Question: How would you classify this visualization?
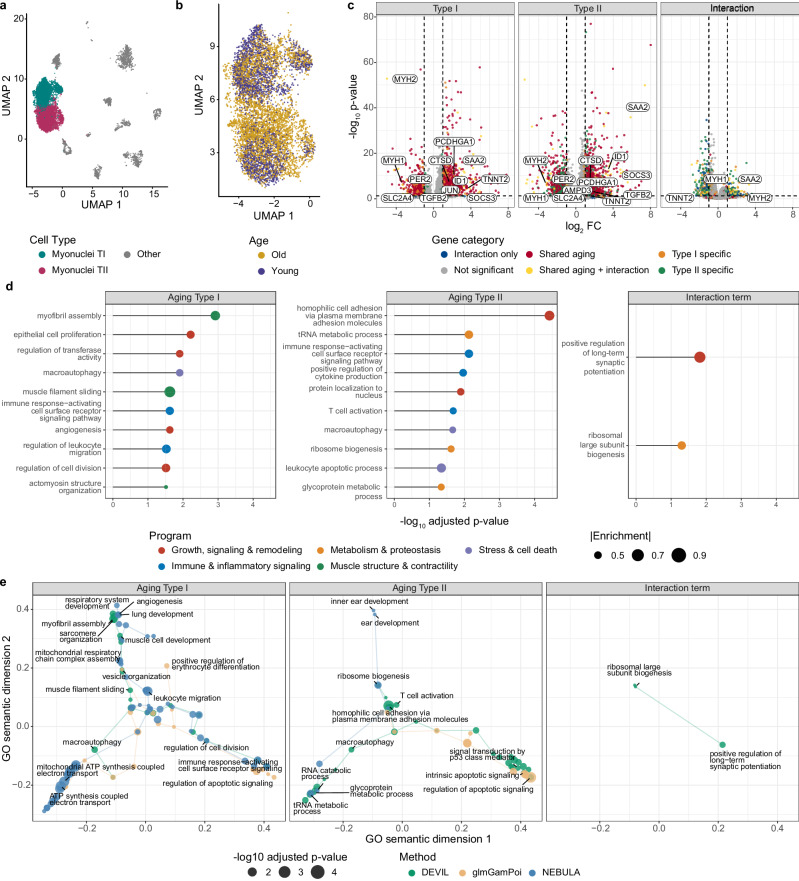
Answer: scatter